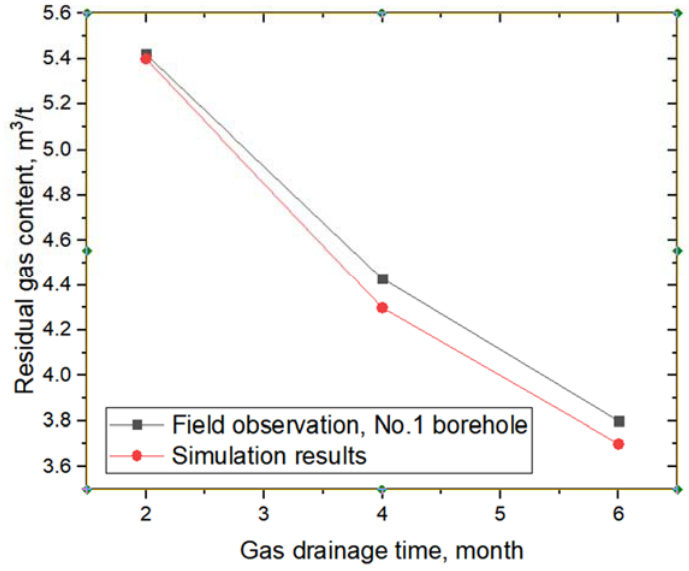
Figure 13. Comparison between field observations and simulation results (4 m borehole size).